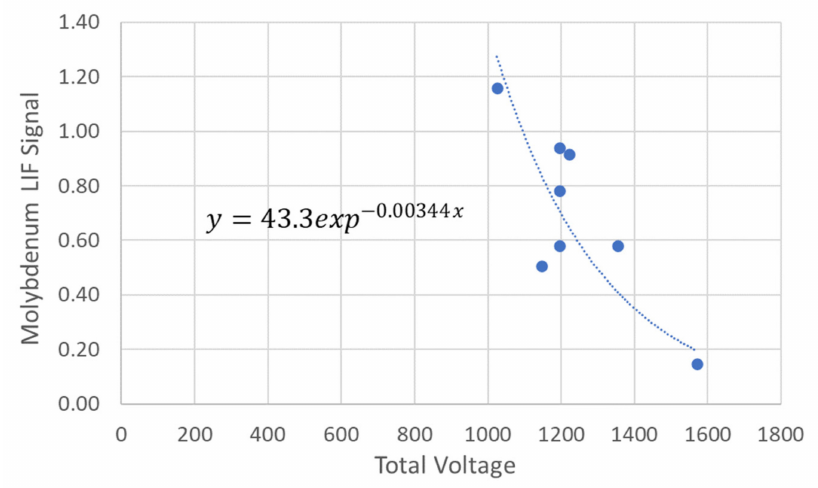
Figure 6. Relative peak density at grid center as a function of nominal total voltage for the throttle conditions included in Figure 5. The data were fit to an exponential function. Most of the plot scatter is due to variations in propellant mass utilization and accel voltage.